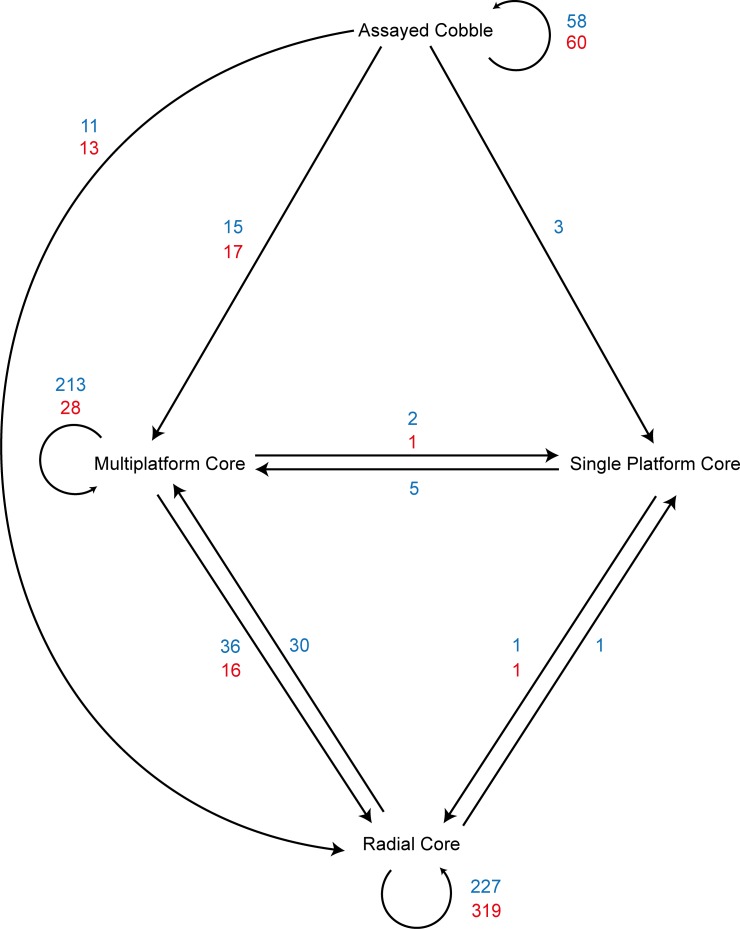
Frequency and direction of transitions between technological core types.Arrows indicate the direction of the transition, and numerals indicate the number of times a transition occurred in the experiments. Cores from the cobble experiments (N = 602) are in blue font, and cores from the flake blank experiments (N = 455) are in red font.